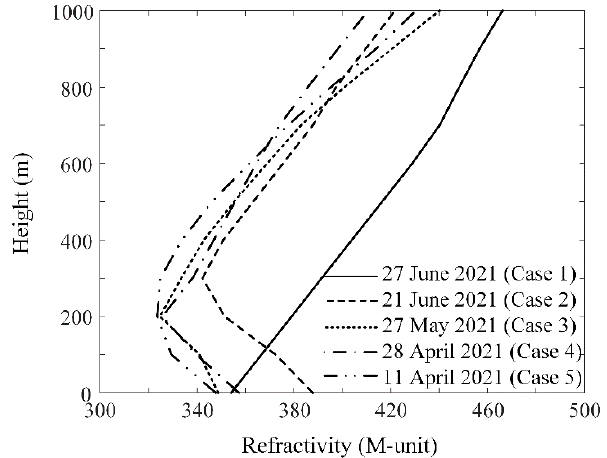
Figure 3. Comparison of the measured atmospheric refractivity for the different atmospheric conditions.